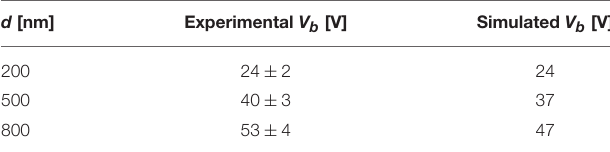
TABLE 1 | Experimental and simulated values of the breakdown voltage V b for the different values of d